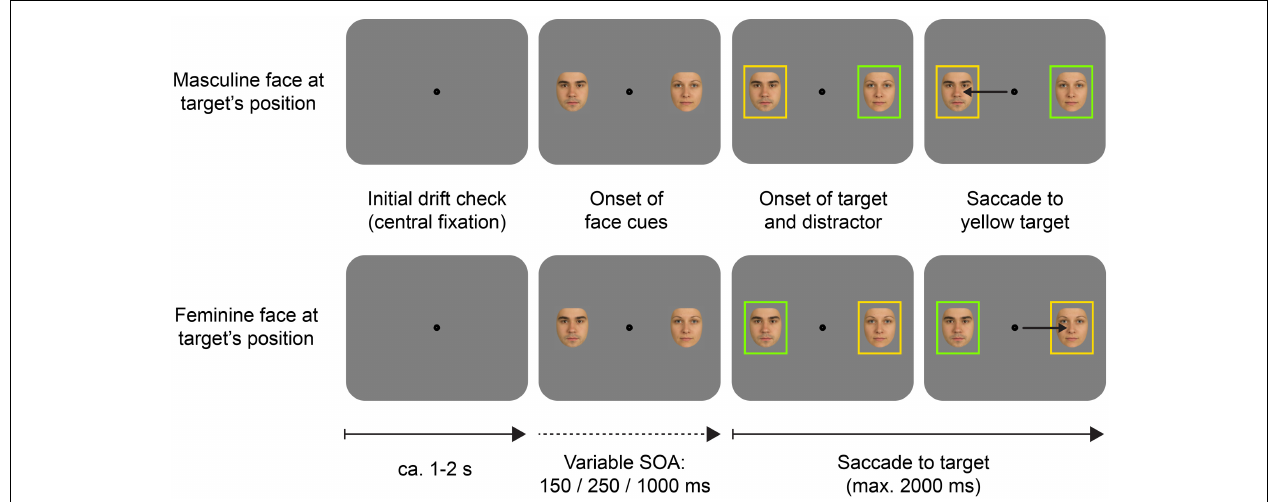
FIGURE 5 | Example schematic trials in the cueing task of Experiment 2. In this example, the target color is yellow, and the distractor color is green (this was counterbalanced across participants). Phenotypic features of the face cues were non-predictive of the upcoming target’s location. SRT to the